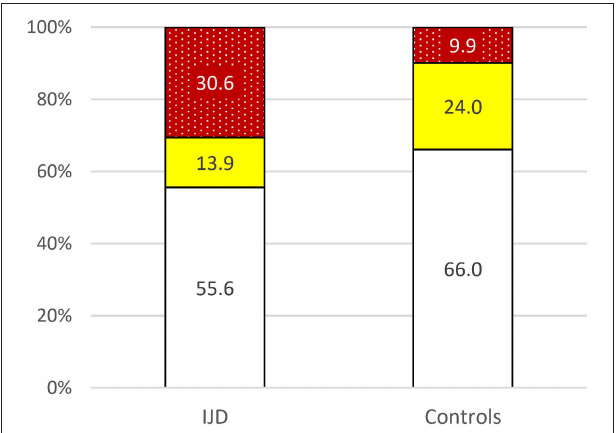
FIGURE 3 | Risk of 10-year cardiovascular mortality in patients with IJD aged 40 to 65 years old and the German control group according to 2016 ESC guidelines on cardiovascular disease prevention but without established CVD for comparison reasons ( p = 0.004) ( low, moderate, high to very high risk; data given in